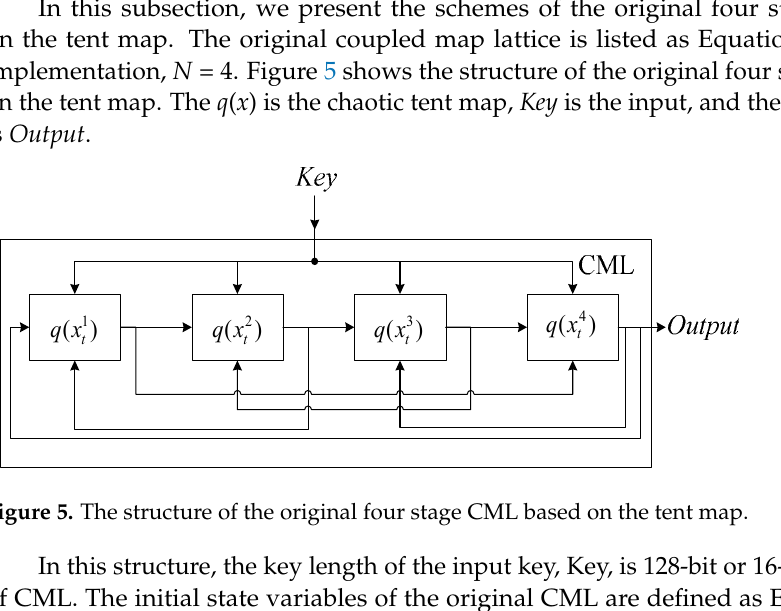
ε = 0.8 ε = 0.8 ε = 0.7 ε = 0.7 ε = 0.5 ε = 0.5 ε = 0.4 ε = 0.4 ε = 0.3